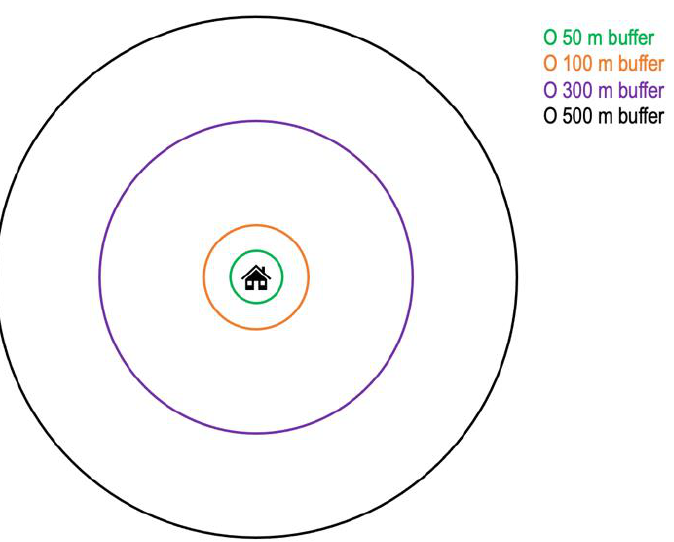
Figure 2. Residential greenspace and green-blue-space exposure assessment within 50 m, 100 m, 300 m, and 500 m egocentric Euclidean buffer zones.